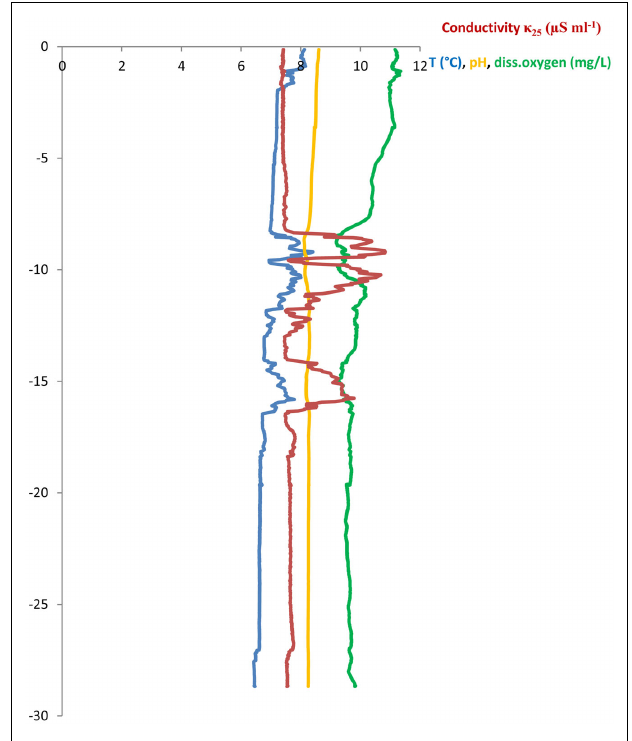
FIGUREA1 | CTD-profile from theVidy Bay, Lake Geneva above the STEPoutlet, recorded onApril 7, 2011.